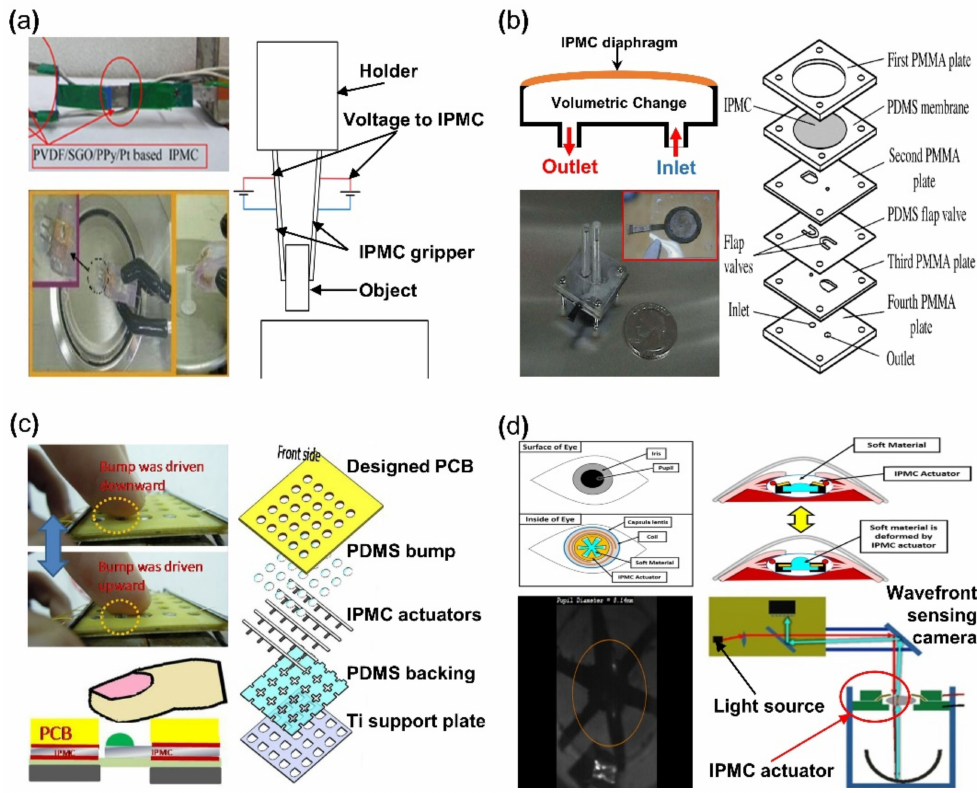
Figure 8. Applications of IPMC actuator. ( a ) Demonstration of IPMC gripper (left). Adapted from Inamuddin et al. [127] with permission from Springer Nature, Copyright (2019) and Feng et al. [101] with permission from Elsevier, Copyright (2007), and corresponding experiment setup (right).